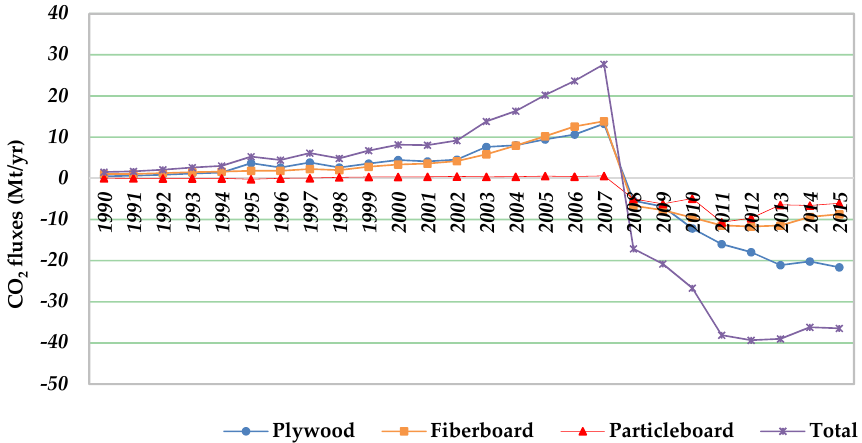
Figure 5. CO 2 fluxes of China’s wood ‐ based panels.